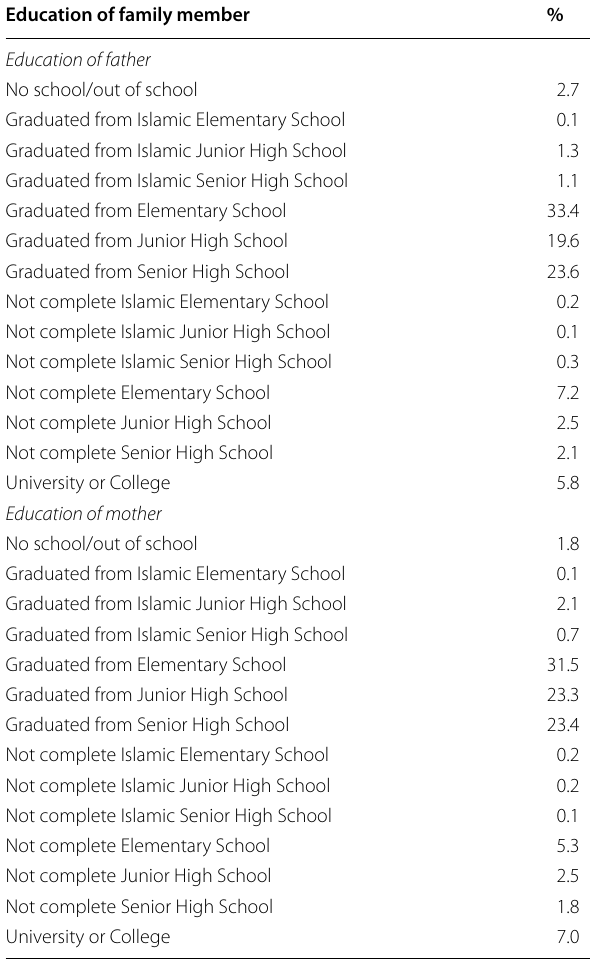
Table 2 Education of family member (n